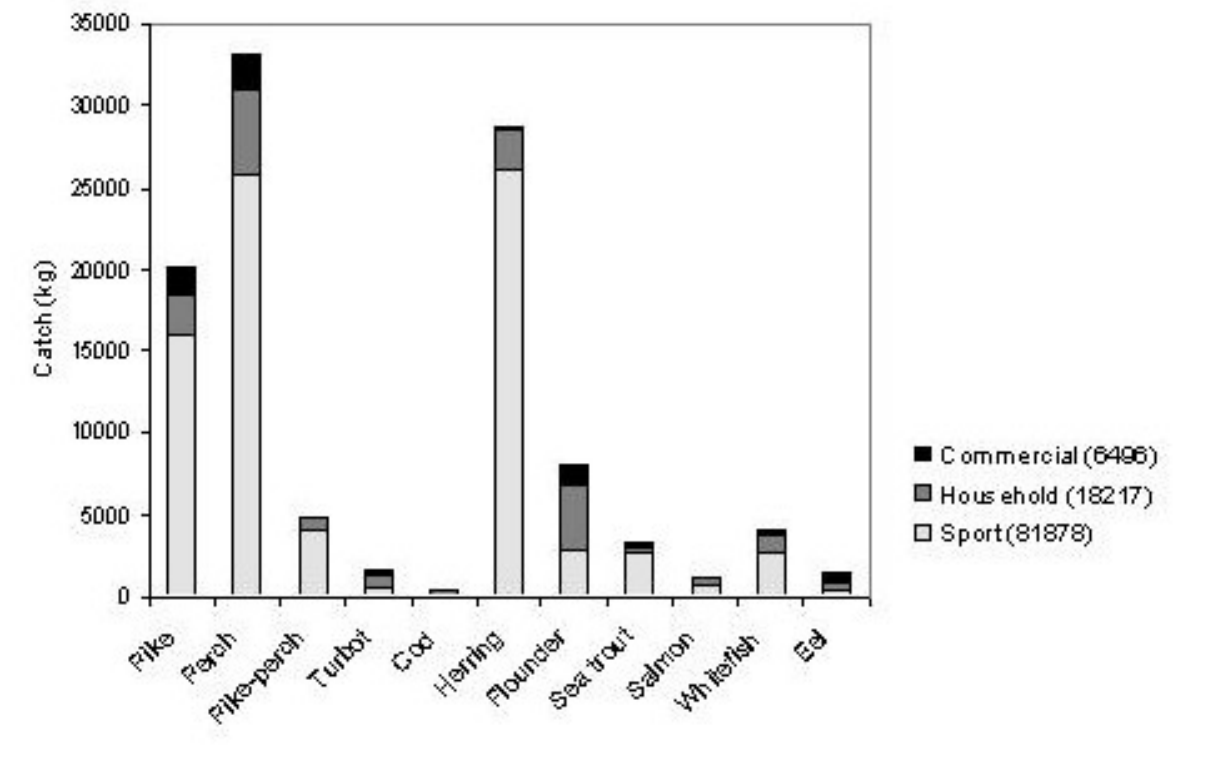
Fig. 4 . Fish catches in Ornö parish in 1995, divided into commercial, household, and sport fishing. (Source: Svedäng et al. 1998, commercial fisheries statistics from the National Board of